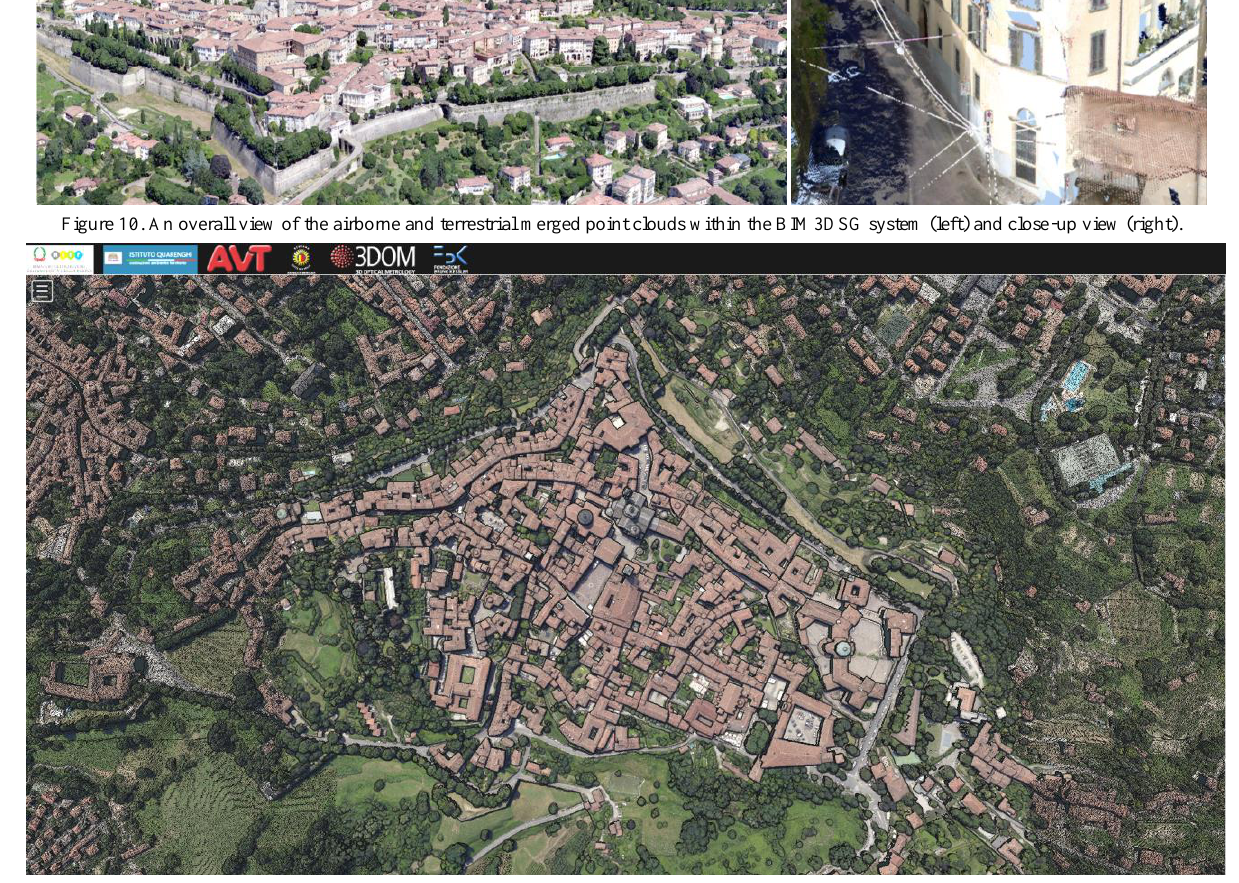
Figure 11. View of the 3D point clouds of Bergamo “Citta’ Alta” (aerial and MMS) visualized within